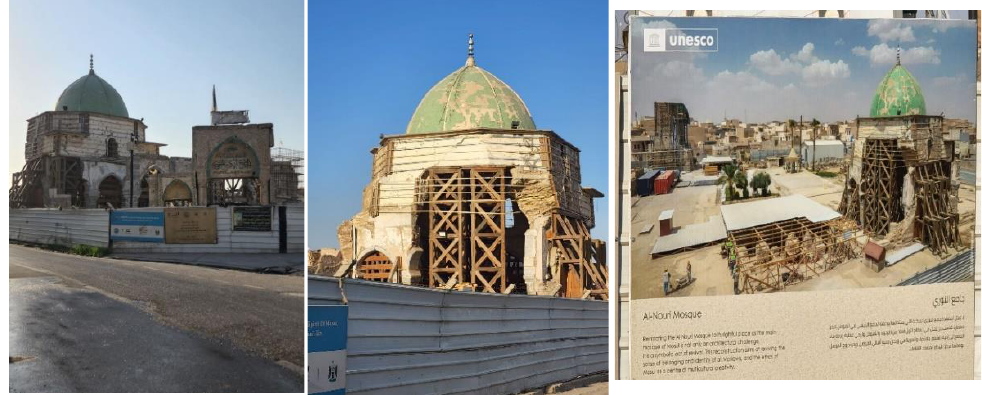
Figure 7. reconstruction of the Great Al-Nuri Mosque and its historical minaret (Al-Hadba) (photo credit: Safaaaldeen ali). credit: Safaaaldeen